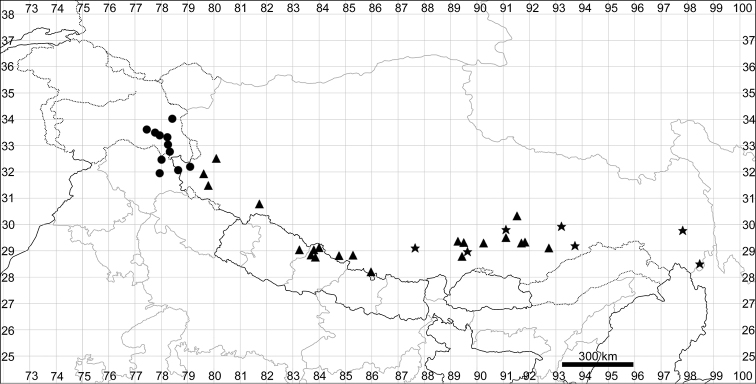
Distribution map of Salsolahartmannii (circles), S.collina (stars) and S.jacquemontii (triangles).